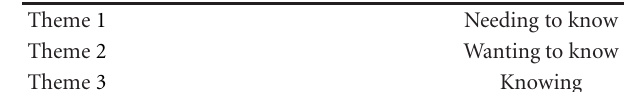
Table 2: Qualitative thematic